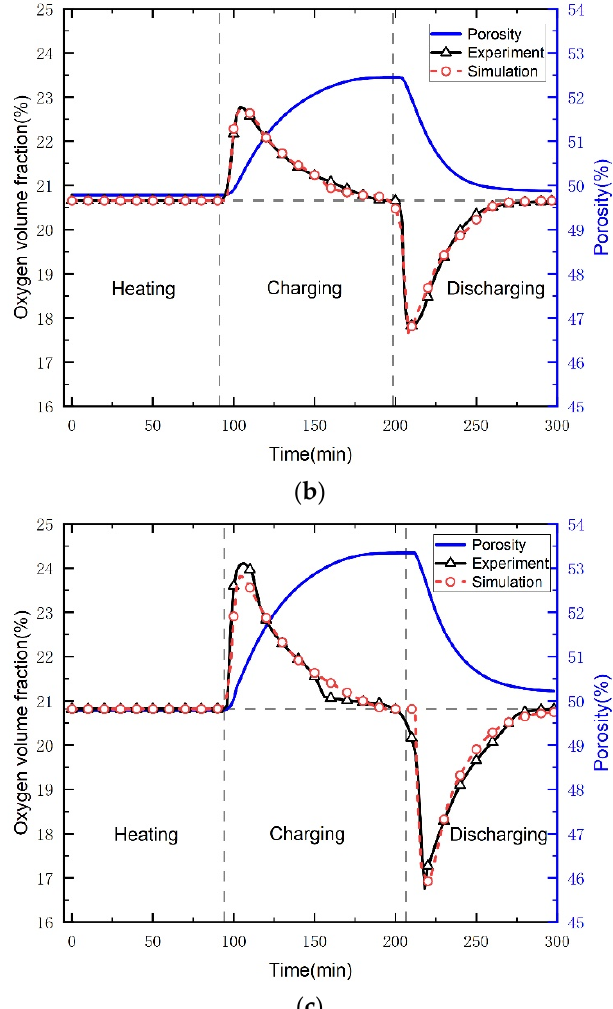
Figure 5. Comparison of experimental and simulation results. ( a ) 970–800 °C temperature window; ( b ) 990–800 °C temperature window; ( c ) 1000–800 °C temperature window.